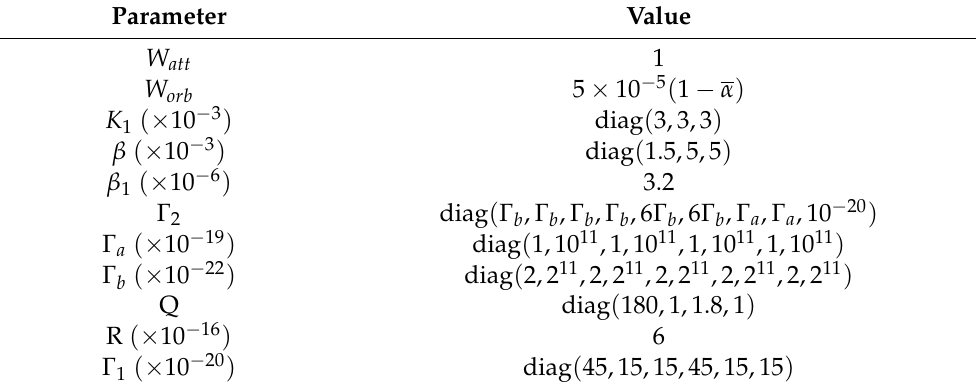
Table 5. Control parameters for the roto-translational